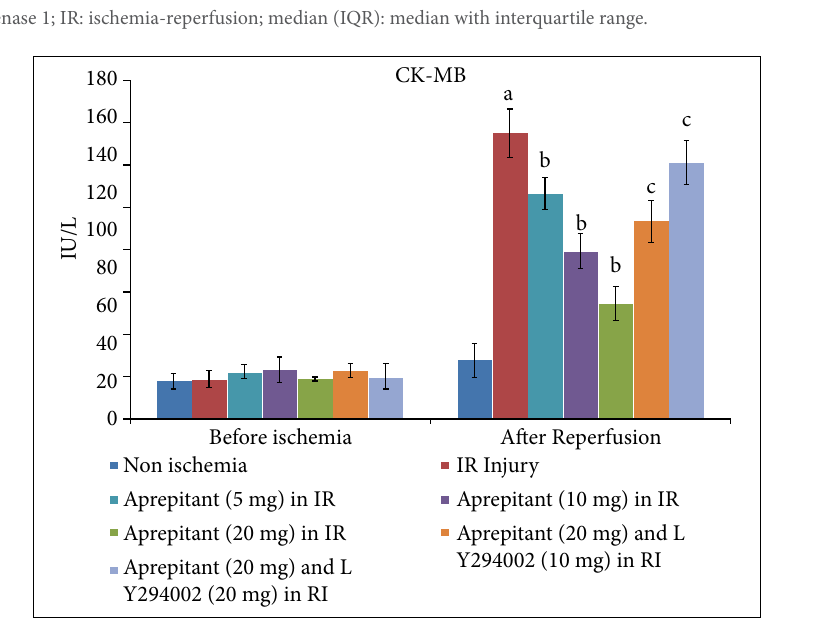
Figure 2 - Effect of aprepitant and LY294002 on ischemia-reperfusion induced CK-MB release in the coronary effluent. Values are given as mean ± SD. (a) p < 0.05 vs . non-ischemia; (b) p < 0.05 vs .